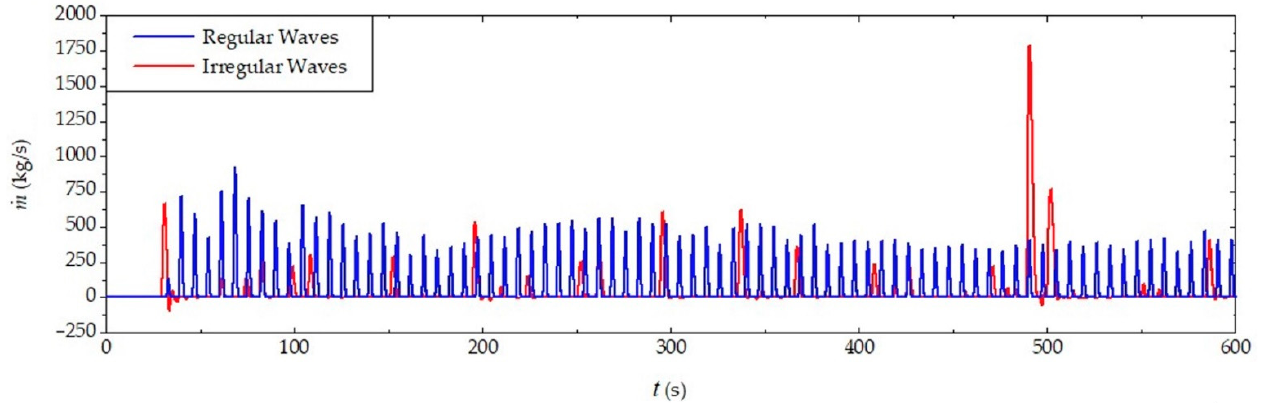
Figure 15. Mass flow rate entering the reservoir due to the incidence of the representative regular waves and realistic irregular waves for TV.